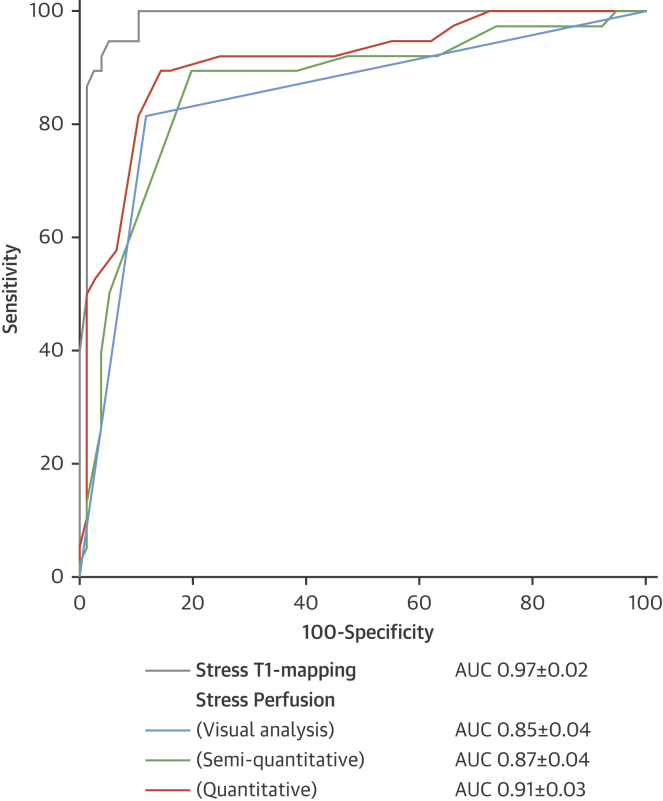
Diagnostic Performance of CMR Stress T1 Mapping (ΔT1) and Gadolinium Contrast–Enhanced Stress Perfusion for Detecting Obstructive CADTrue positive: myocardial segments downstream of obstructive coronary arteries (FFR <0.8); true negative: myocardial segments downstream of nonobstructive coronary arteries (FFR ≥0.8). Area under the curve (AUC), all p < 0.001. Stress T1 mapping (AUC: 0.97 ± 0.02; p < 0.001) had significantly higher diagnostic performance than stress perfusion CMR by visual (AUC: 0.85 ± 0.04; p < 0.001), semi-quantitative (AUC: 0.87 ± 0.04; p < 0.001) and quantitative (AUC: 0.91 ± 0.03; p < 0.001) analyses for detecting obstructive FFR <0.8 epicardial coronary artery disease (CAD) (all comparisons p < 0.01). The different methods of perfusion CMR analysis did not differ significantly in diagnostic performance for detecting significant CAD (all p > 0.22). Data are based on 125 coronary artery territories in 60 patients. AUC = area under the receiver-operating characteristic curve; other abbreviations as in Figure 2.